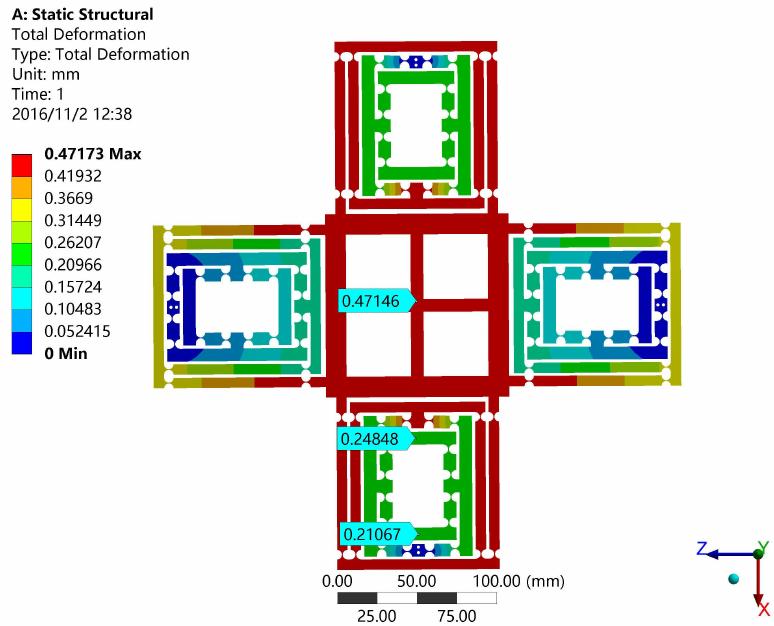
Figure 10. The output compliance simulation results of